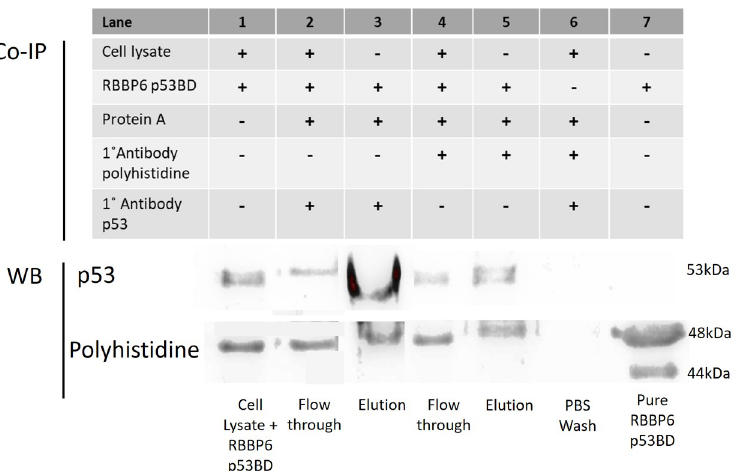
Fig 9. Western blot analysis of Co-IP assays performed using anti-p53 and anti-polyhistidine on HEK293 T cells. Two separate Western blots were performed to investigate the presence of endogenous p53 and recombinant polyhistidine-tagged RBBP6 p53BD in Co-IP assays performed using protein A agarose with anti-p53 (lanes 2 and 3) and anti-polyhistidine (lanes 4 and 5) as probes. Lane 1 contains the HEK293 T cells cell lysate with purified RBBP6-p53BD which was used in Co-IP assays. Lanes 2 contains the flow-through from the anti-p53 Co-IP assay which consists of the proteins in the cell lysate that did not bind with the p53 antibody. Lanes 3 contains the immuno- complexes isolated during the anti-p53 Co-IP assays. Lanes 4 contains the flow-through from the anti-polyhistidine Co-IP assay which consists of the proteins in the cell lysate that did not bind with the polyhistidine antibody. Lane 3 contains the immuno-complexes isolated during the anti-polyhistidine Co-IP assay. Lane 6 contains the PBS collected from washing the agarose beads before elution for both Co-IP assays combined. Lane 7 contains purified RBBP6-p53BD as a control. Lane 3 in both blots was overexposed, and therefore a shorter exposure time was used for this lane and overlaid on top.